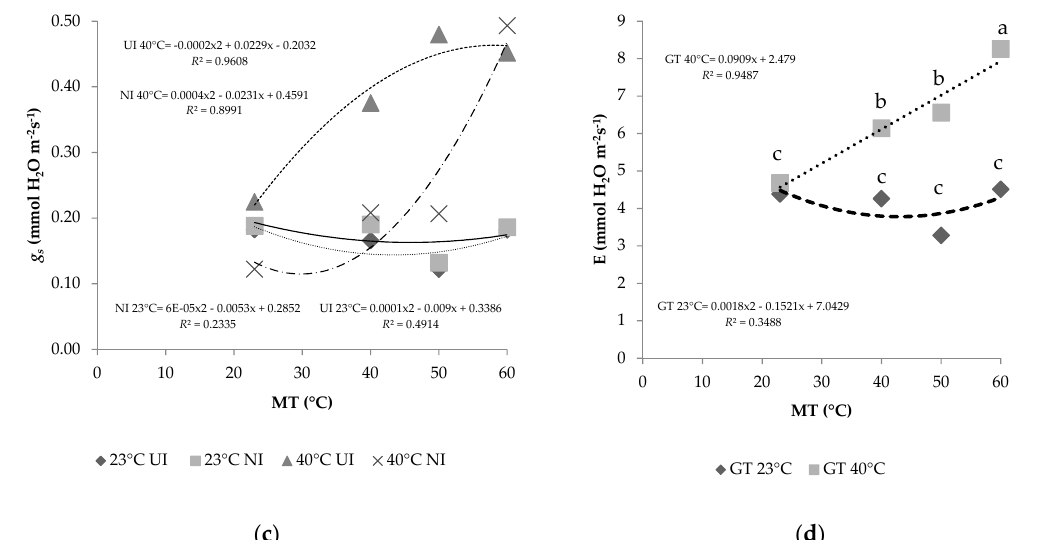
Figure 8. Water potentials and gas exchange parameters in plants with greenhouse temperature (23 or 40 °C) under (UI) irrigation or no irrigation (NI) conditions (I) obtained from EMs of Pinus radiata D.Don submitted to different maturation temperatures (MT). ( a ) Leaf water potentials ( Ψ leaf ) initial and final (applying of these treatments), ( b ) instantaneous net photosynthesis ( A N , µmol CO 2 m − 2 s − 1 ), ( c ) stomatal conductance ( g s , mmol H 2 O m − 2 s − 1 ), and ( d ) instant transpiration ( E , mmol H 2 O m − 2 s − 1 ). Different letters show significant differences by the Tukey–Kramer test ( p ≤ 0.05). Table 4. ANOVA for the e ff ect of di ff erent maturation temperatures (MT) in the instantaneous net photosynthesis ( A N , µ mol CO 2 m − 2 s − 1 ), stomatal conductance ( g s , mmol H 2 O m − 2 s − 1 ), and instant